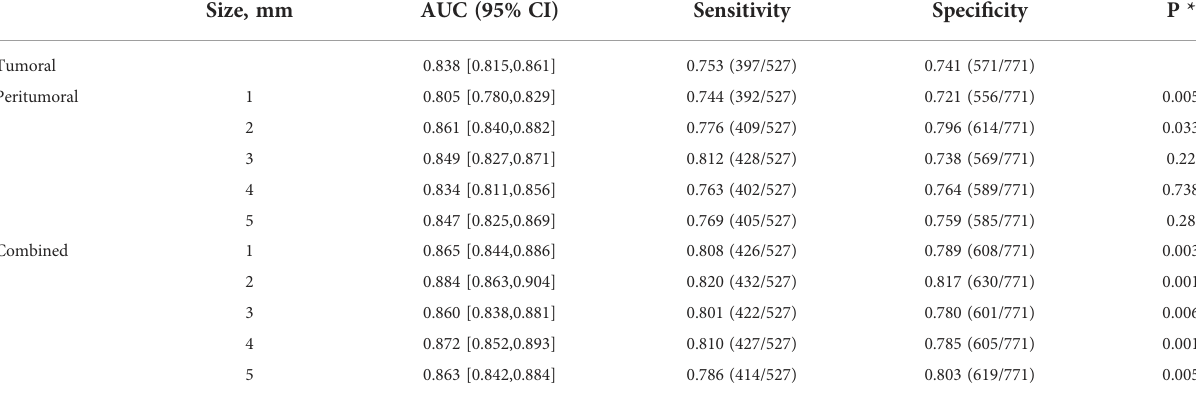
TABLE 4 Benign/malignant classi fi cation performance of deep learning models in patient